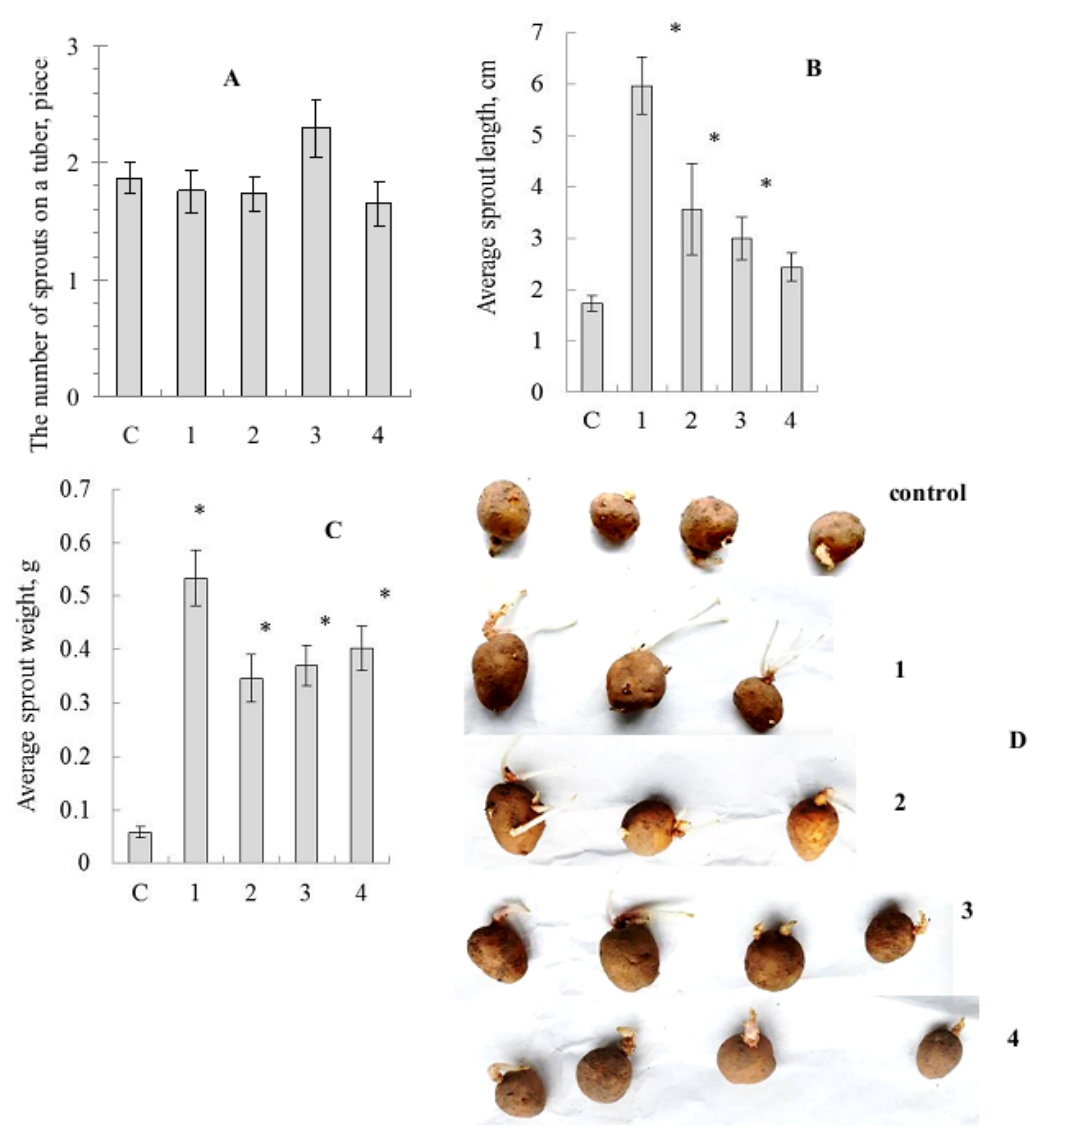
Figure 3. Influence of treatment by the mushroom-based Se-nanocomposites on potato tuber germination. ( A )—mean number of sprouts per tuber, ( B )—mean sprout length, ( C )—mean sprout biomass, ( D )—photo of tubers; c—control (distilled water), 1— Grifola umbellata , 2— Ganoderma lucidum 1315, 3— Pleurotus ostreatus , 4— G. lucidum SIE1303; * p ≤ 0.01 compared to control.